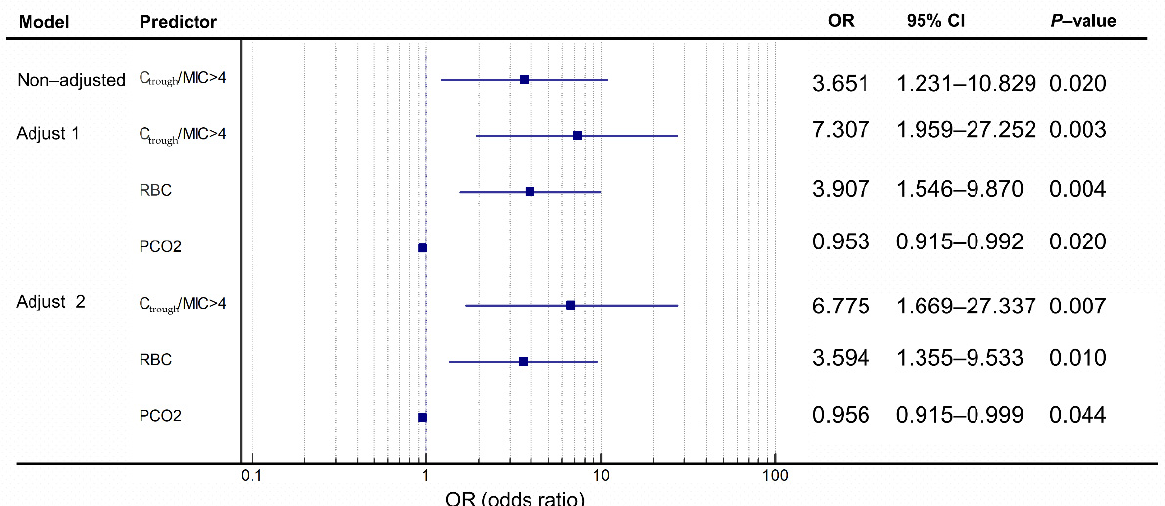
Figure 3. Distinction of treatment outcome in different groups of C trough /MIC and C/MIC. ( A ) Num- ber of trough concentrations ( n = 70), ( B ) Number of concentrations ( n = 139). C trough , trough mero- penem concentration; C, overall meropenem concentration; MIC, minimum inhibitory concentra- tion; * represents p < 0.05, ** represents p < 0.001.